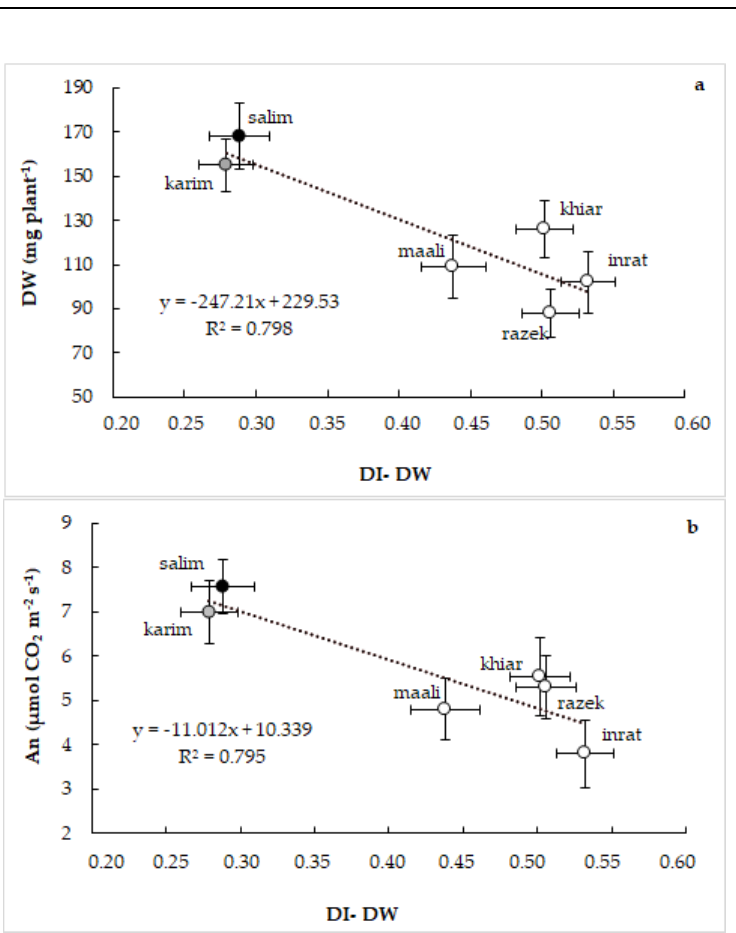
Figure 5. Relationship between plant growth (DW) and drought index based on dry weight (DI-DW, Figure 5 a ), and between net photosynthesis (An) and drought index based on dry weight (DI-DW, Figure 5 b ) in six Tunisian genotypes of durum wheat ( Triticum durum Desf.) subjected to drought stress. Vertical and horizontal standard errors of means of 30 replicates.